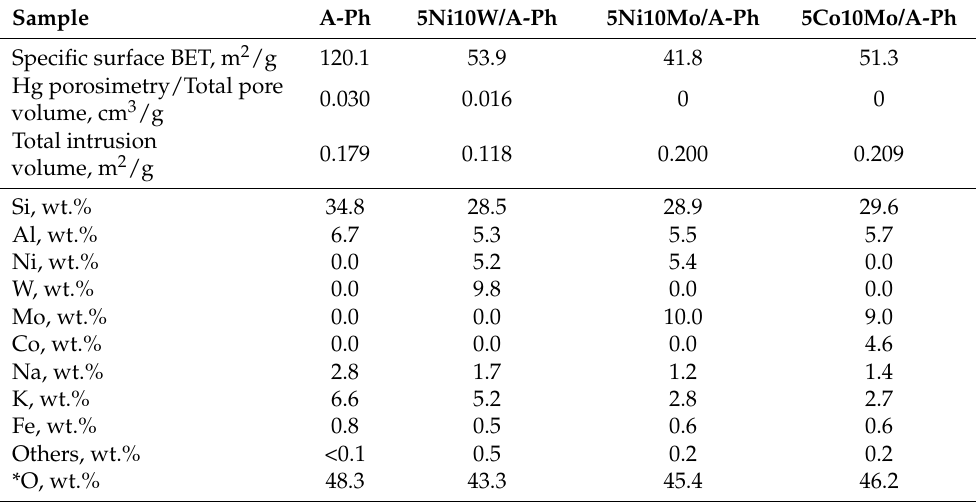
Table 6. XRD analysis of the utilized support material (A-Ph) and created catalysts. Textural properties of a phonolite-derived solids by Hg porosimetry and N 2 physisorption